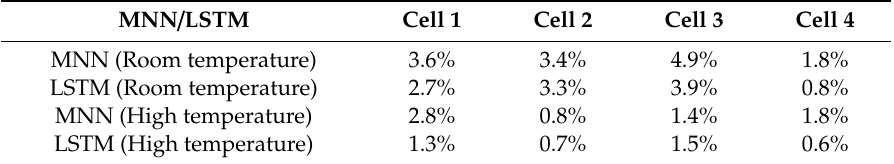
Table 6. SOC estimation results of using the MNN and LSTM at room temperature and high